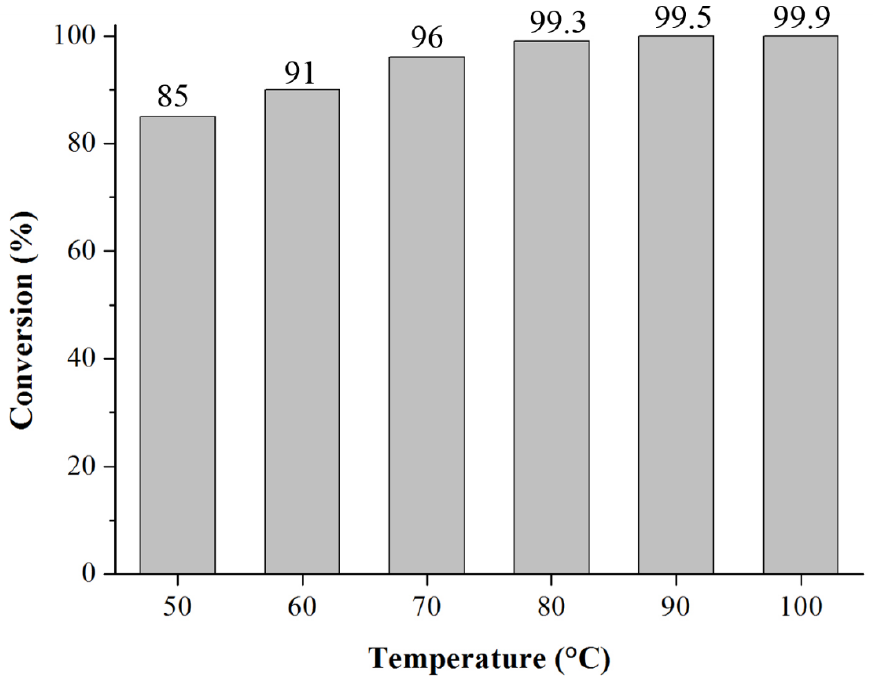
Figure 6. Percentage conversions of eugenyl acetate varying the reaction temperature. Reaction conditions: eugenol: acetic anhydride (1:5), reaction time 40 min and 2% catalyst.